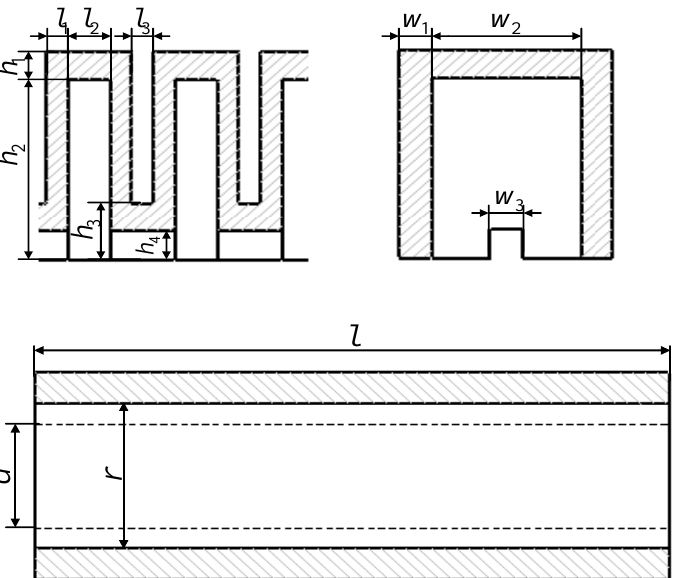
Figure 5. Schematic diagram of structural dimensions of hexagonal prism soft-bodied bionic actu- ator.